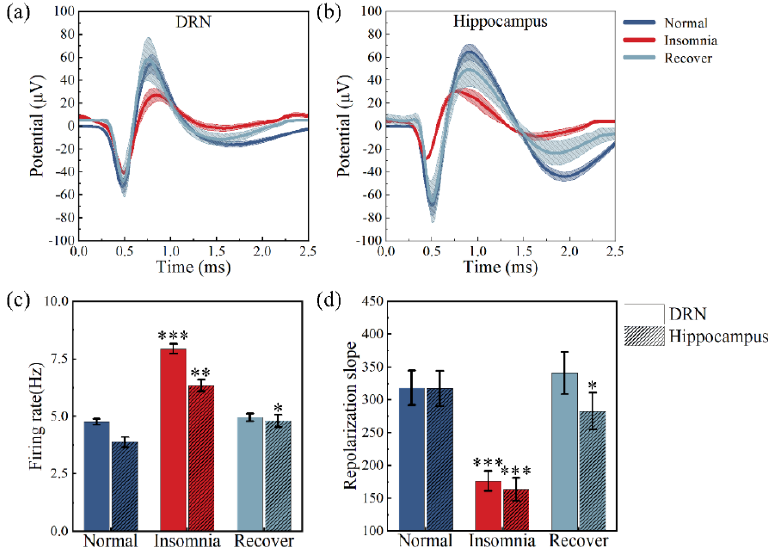
Figure 7. Statistics for spike waveform and firing rate of the rats’ dorsal raphe nucleus (DRN) and hippocampus in normal, insomnia and recovery states ( n = 12). ( a ) Spike waveform statistics in the DRN; ( b ) Spike waveform statistics in the hippocampus; ( c ) Statistics for neural firing rate in the DRN and hippocampus; ( d ) Repolarization slope of spikes in the DRN and hippocampus. (* p < 0.05, ** p < 0.01, *** p < 0.001, compared to normal in the same brain region).